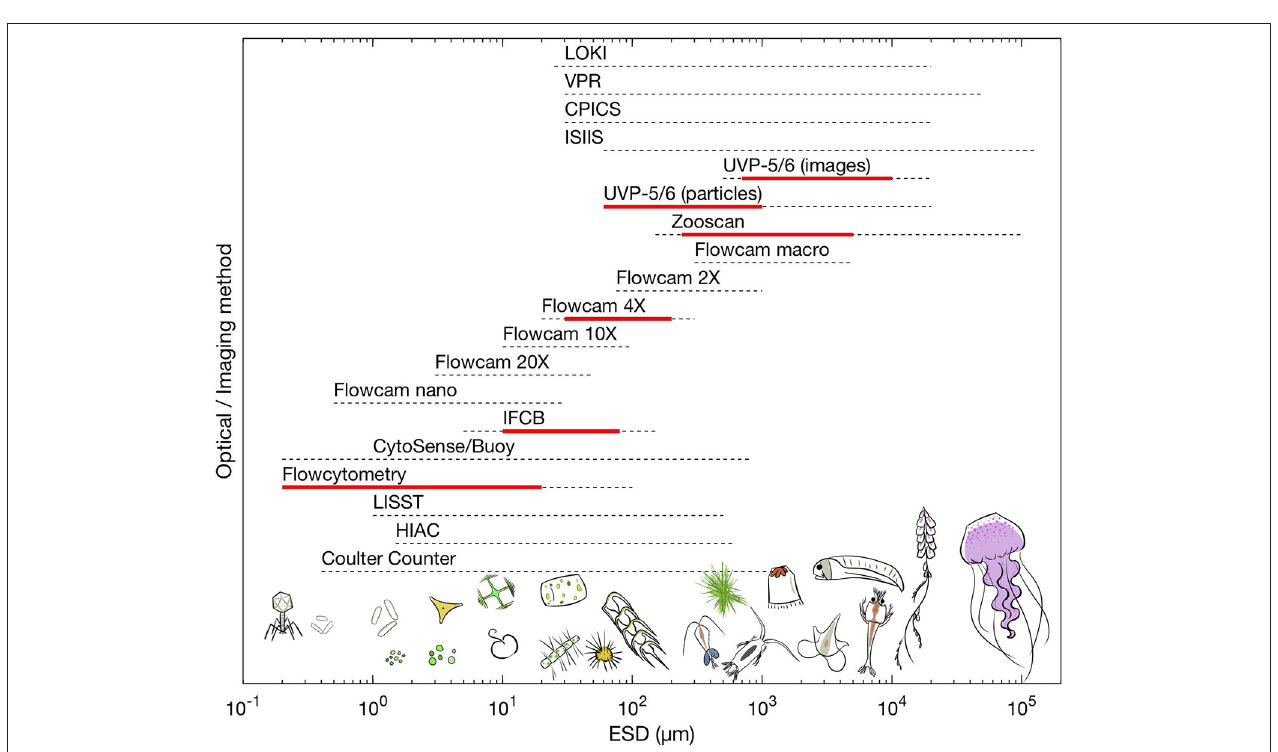
FIGURE 1 | Comparison of the total size range of plankton (in equivalent spherical diameter; ESD) that available optical and imaging methods can sample. Dashed lines represent the total operational size range from commercial information while the red line represent the practical size range which is efficient to obtain quantitative information, for an example see Figure 2 . Drawings by Justine